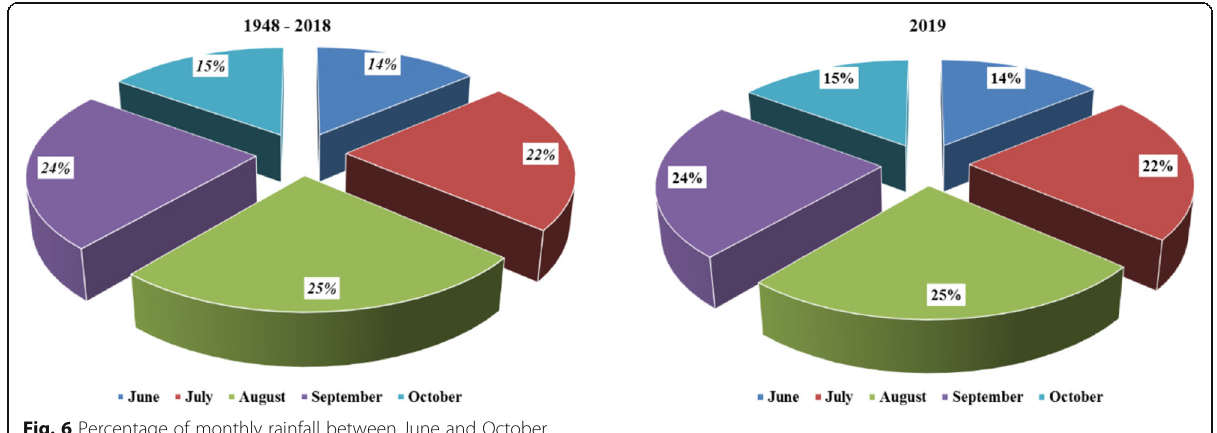
Fig. 6 Percentage of monthly rainfall between June and October